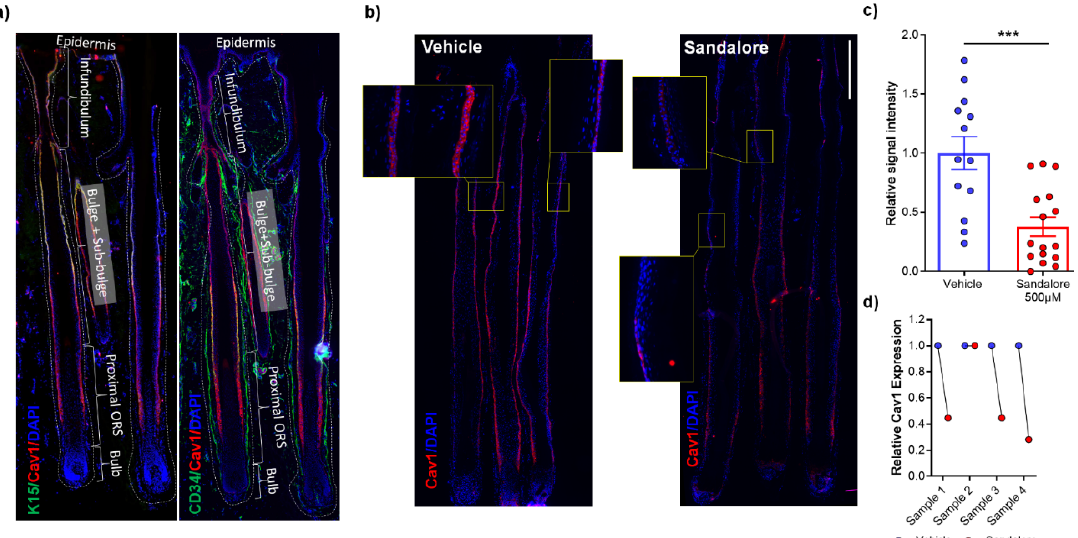
Figure 2. Caveolin-1 colocalizes with markers of eHFSCs in the outer root sheath cells in human hair follicles. ( a ) Cav1 immunostaining of normal human scalp hair follicles exhibits colocalization with K15 and CD34, common markers of eHFSC in ORS cells. ORS-Outer Root Sheath. Treatment of normal human scalp hair follicles with Sandalore results in downregulation of Cav1 expression in the bulge at both protein ( b , c ) and mRNA levels ( d ). Data are expressed as mean ± SEM, n = 13–16 HFs from 2 different donors, Student’s t -test, *** p < 0.001, GraphPad Prism 6.